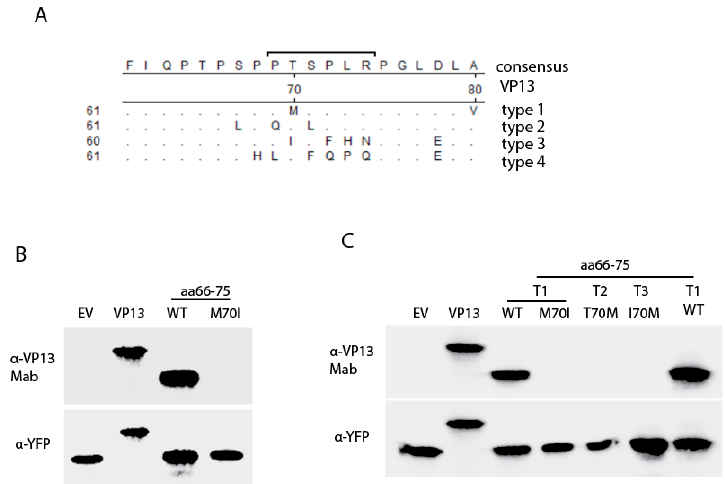
Figure 4. The M70 residue of the epitope is essential for the VP13 Mab binding. ( A ) Alignment of amino acid sequence of VP13 from the four genotypes (genotype 1 Sar55 strain (GenBank accession #AF444002), genotype 2 Mexican strain (GenBank accession# M74506), genotype 3 Kernow ‐ C1 strain (GenBank accession# HQ709170), and genotype 4 JAK ‐ Sai strain (GenBank accession# AB074915). The alignment of residues 61 to 80 is shown. The numbers between the two lines indicate amino acid number of VP13. Identical residues to consensus sequence are shown as “.” and different residues are shown. The PXXP motif is indicated by a solid line above the residues 69–74; ( B ) The VP13 Mab binds to aa66 – 75 peptide and M70 residue is essential for interaction. HEK293 cells were transfected with the VP13, VP13aa66 – 75 and VP13aa66 – 75 ‐ M70I, and harvested for immunoblotting with VP13 Mab; ( C ) Mutation of residue 70 of type 2 and 3 VP13 to methionine is unable to have the peptide aa66–75 of type 2 and 3 interact with the VP13 Mab. WT: wild type.